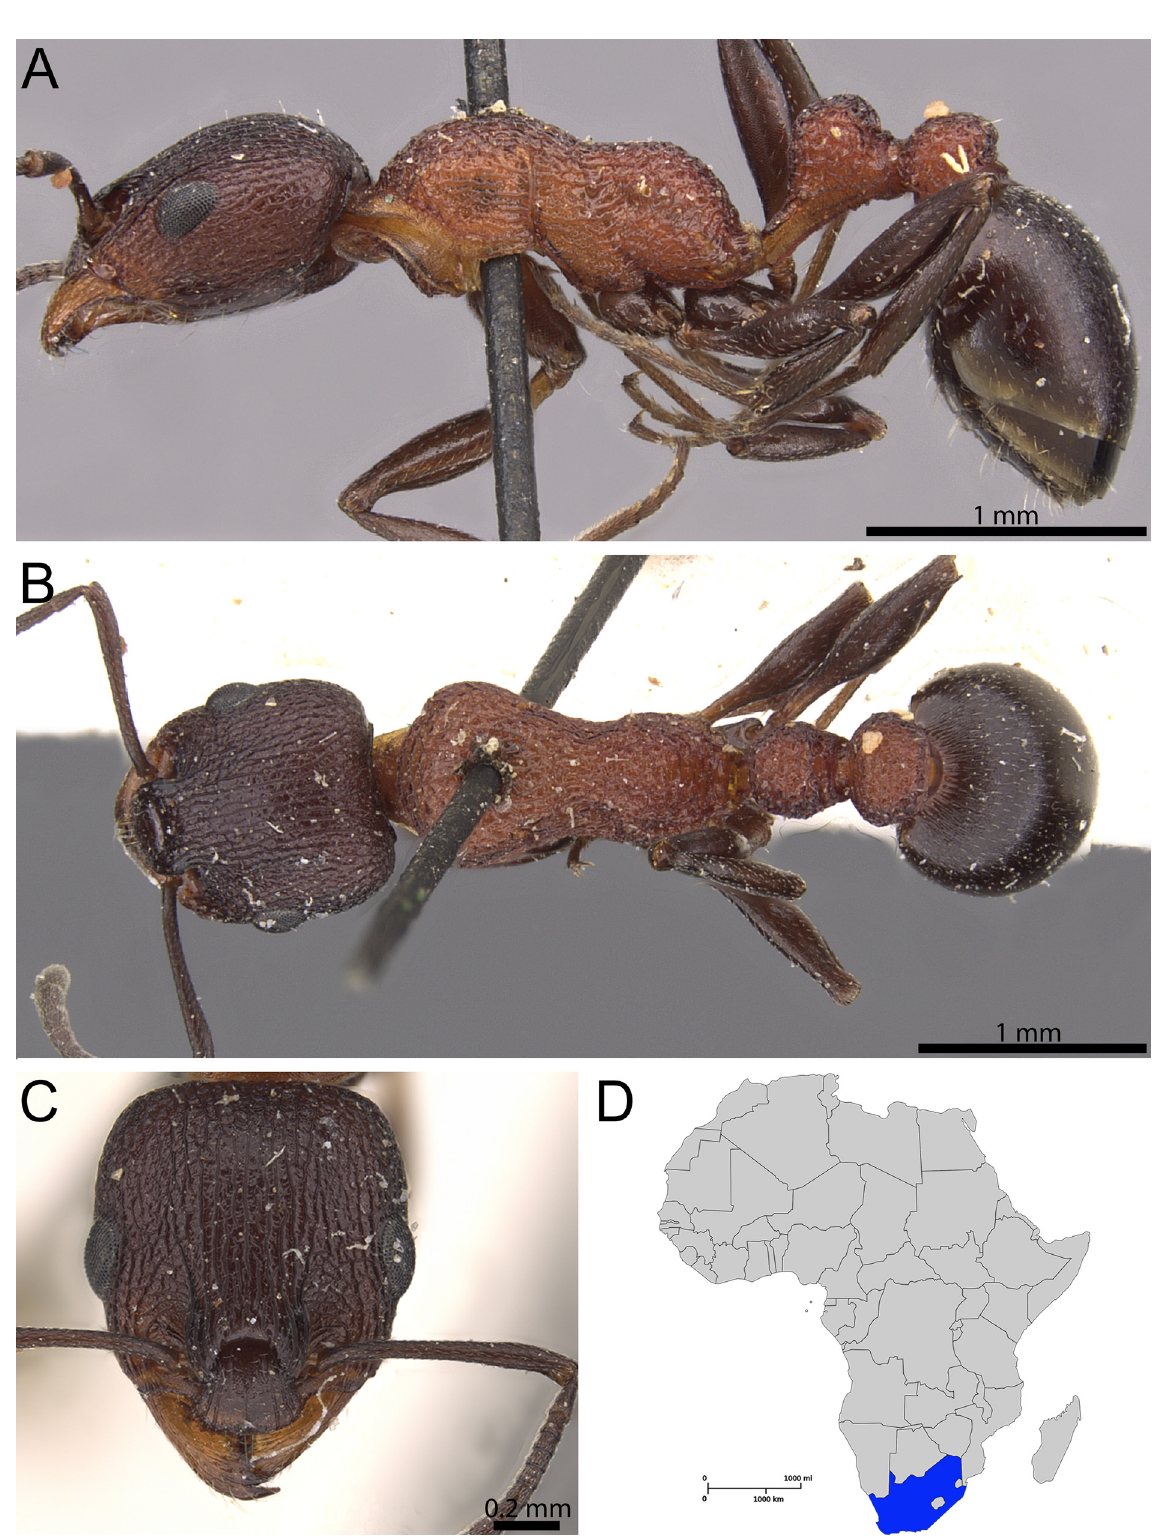
Fig. 7. Nesomyrmex braunsi (Forel, 1912) (CASENT0909209). A . Body in profile view. B . Body in dorsal view. C . Head in full-face view. D . Map of Africa and Madagascar showing currently known